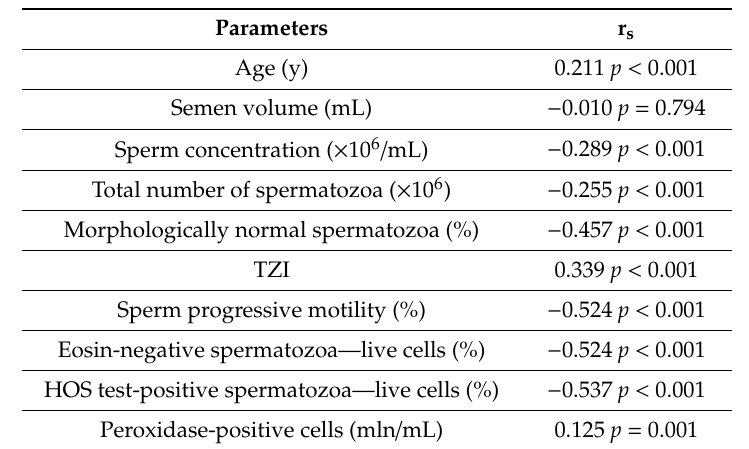
Table 5. Rank Spearman correlations (r s ) between human sperm chromatin fragmentation (SDF), male age and standard semen parameters (n =